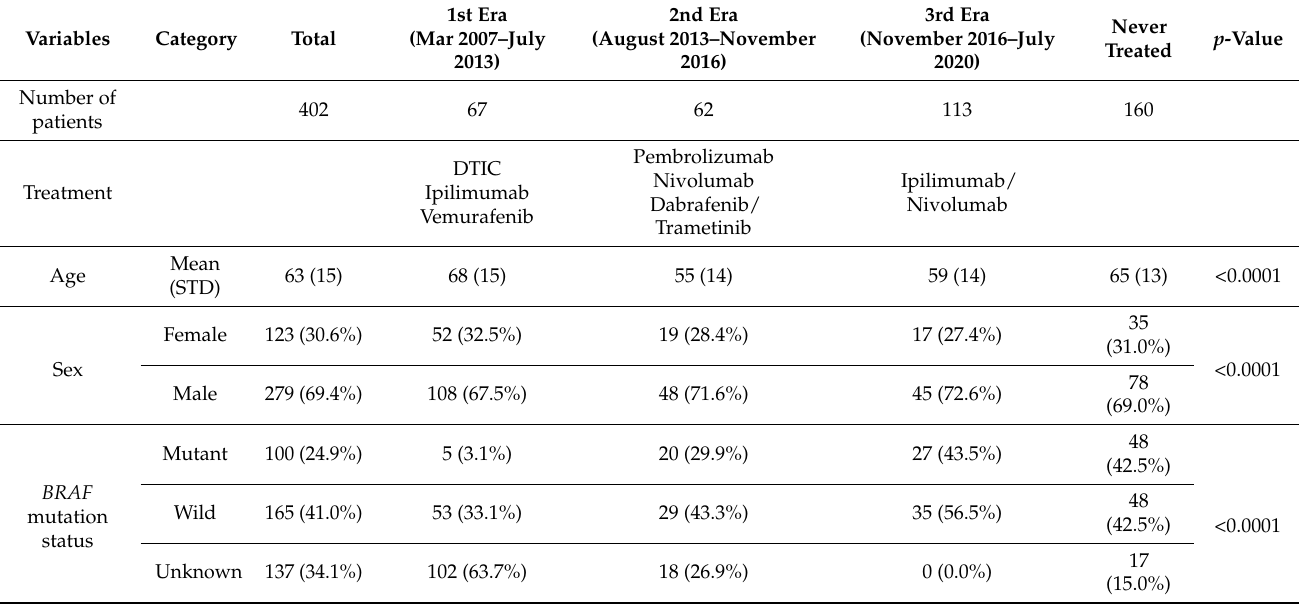
Table 1. Treatment Eras and New Agent